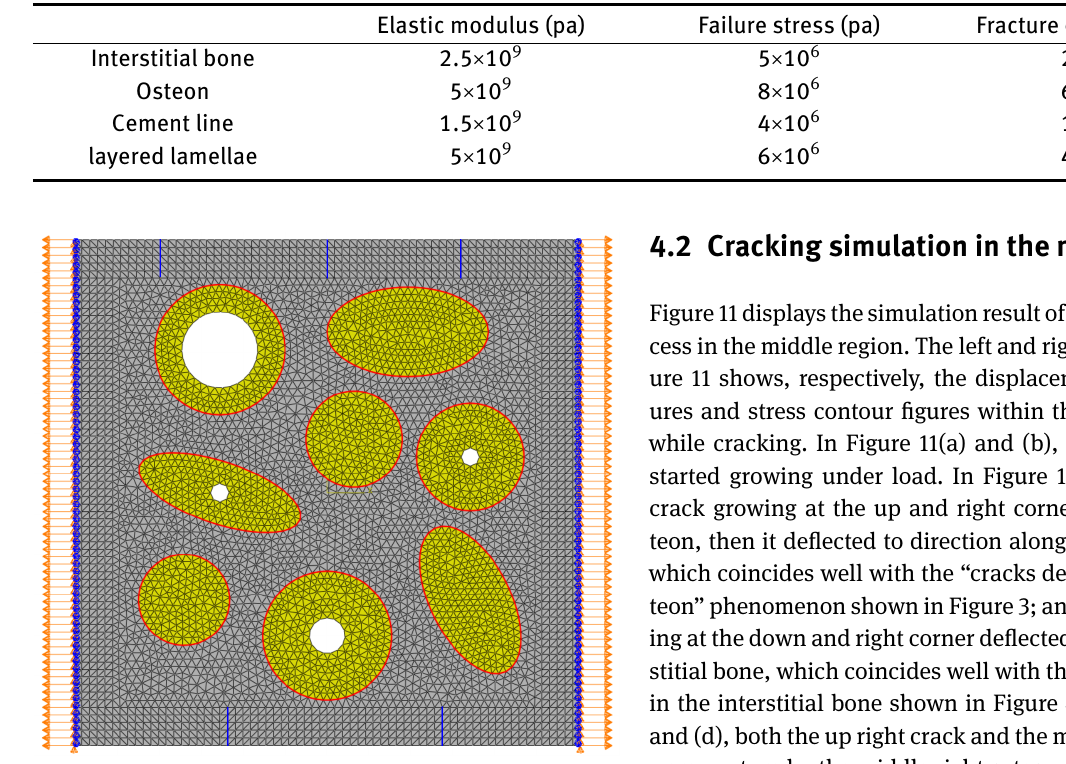
Table 1: Properties used for middle region simulation.